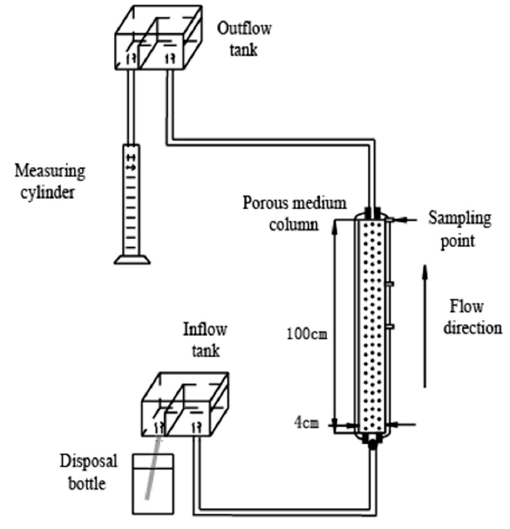
Figure 1. Experimental setup.